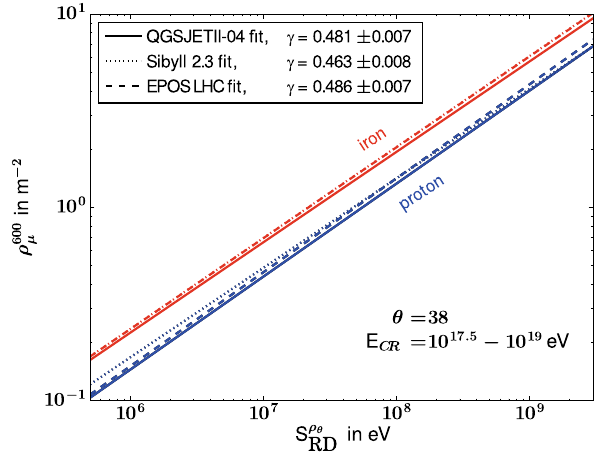
Fig. 9 The correlation between the muon density and the radiation energy (as in Fig. 8) using different hadronic models. The average index γ of a power-law fit to the proton and iron distributions shows only minor differences. Therefore, only QGSJETII-04 is used for all following investigations